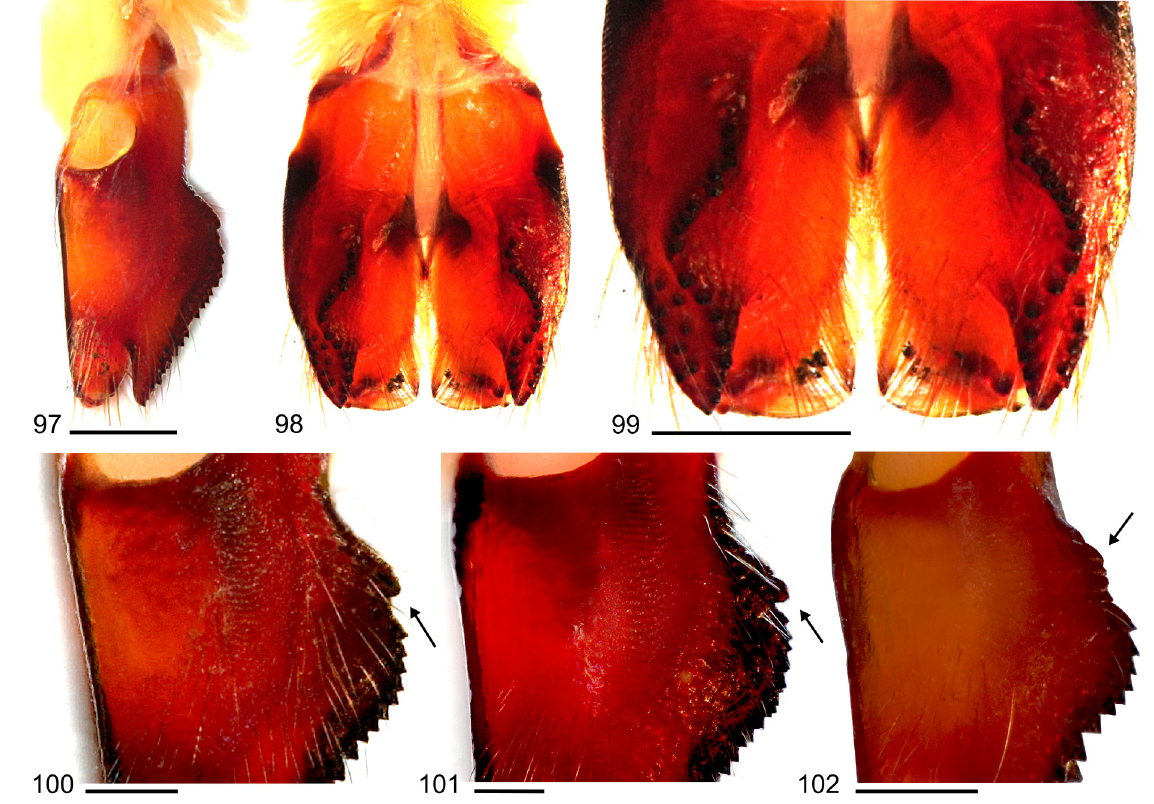
Figs 97–102. Artema doriae Thorell, 1881, male chelicerae in lateral and frontal views. 97–99 . Iran, Tehran (MNHN Ar 10180). 100–101 . Iran, Tehran (ZFMK Ar 15233 and SMF). 102 . Israel, Yavni’el (HUJ Ara 16030). Arrows = projections proximally on frontal process. Scale lines: 97–99 = 0.5 mm; 100–102 = 0.2